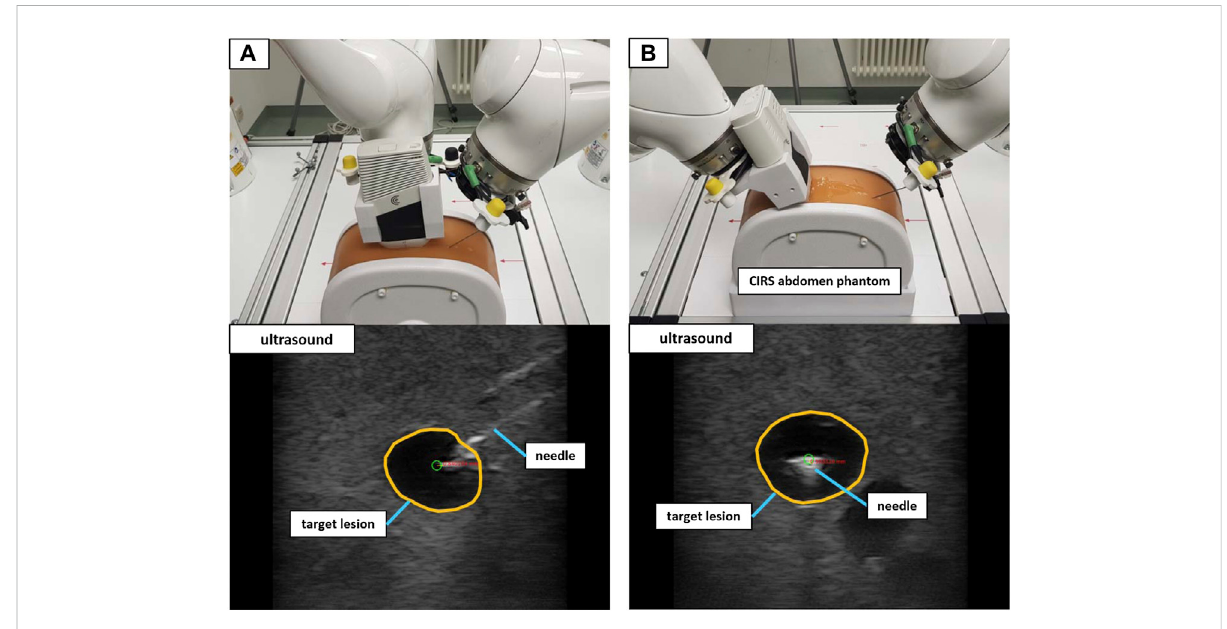
FIGURE 9 The validation setup to puncture lesions inside an abdominal phantom with trajectory hand guidance. Shown are the in-plane positioning (A) and orthogonal positioning (B) for the same target lesion. The green circle marks the planned needle tip position.